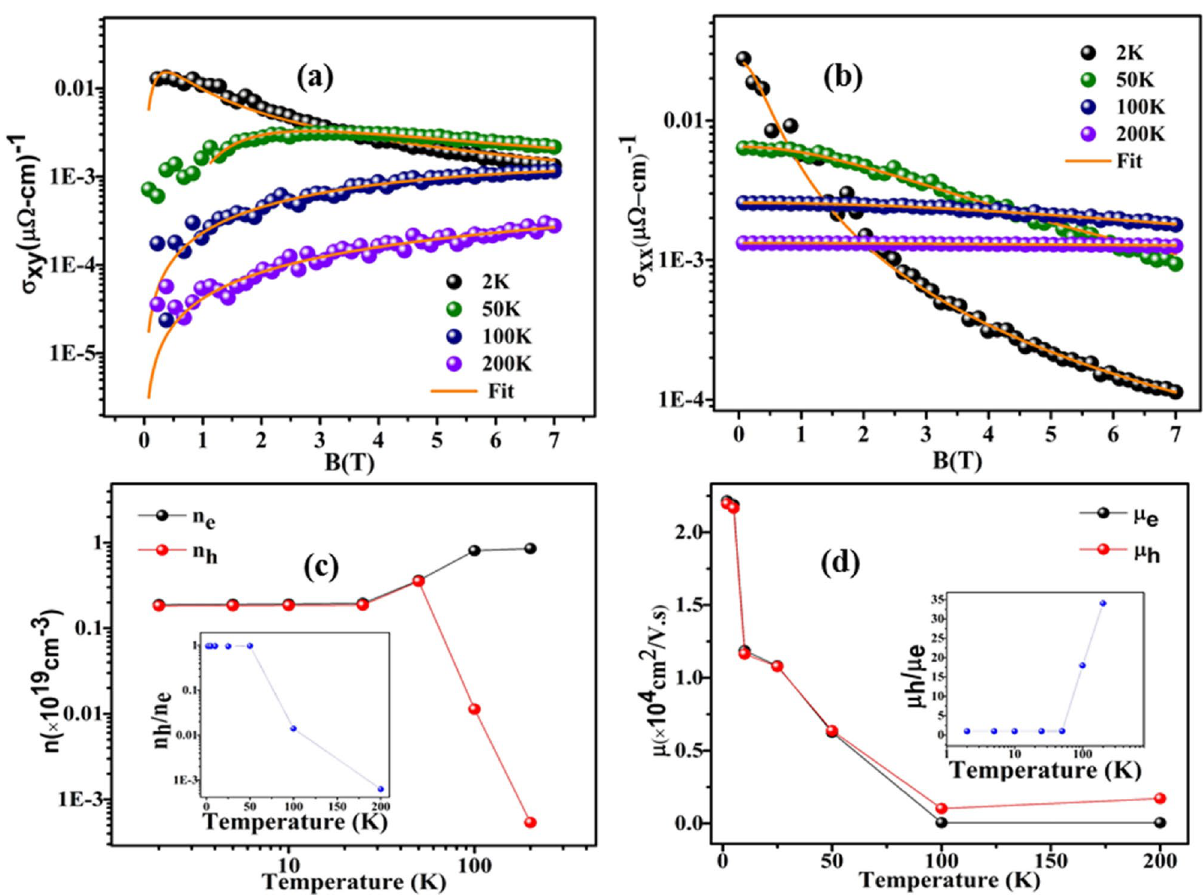
Figure 2. ( a , b ) Field dependence of Hall conduvtivity σ xy and longitudinal conductivity σ xx at 2,50,100 and 200 K, orange solid lines are their respective two-carrier model fit with Eqs. (1) and (3), ( c ) density of electrons n e (black circle) and density of hole n h ( red circles) as a function of temperature extracted from σ xy , inset: ratio of n h and n e as a function of temperature, ( d ) electron mobility μ e (black circle) and hole mobility μ h ( red circles) and their ratio μ h /μ e, inset: as a function of